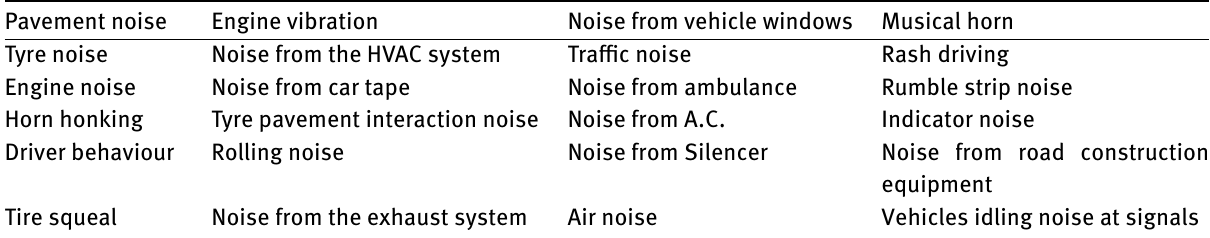
Table 2: Urban road traflc noise keywords indicating suitable types of noise